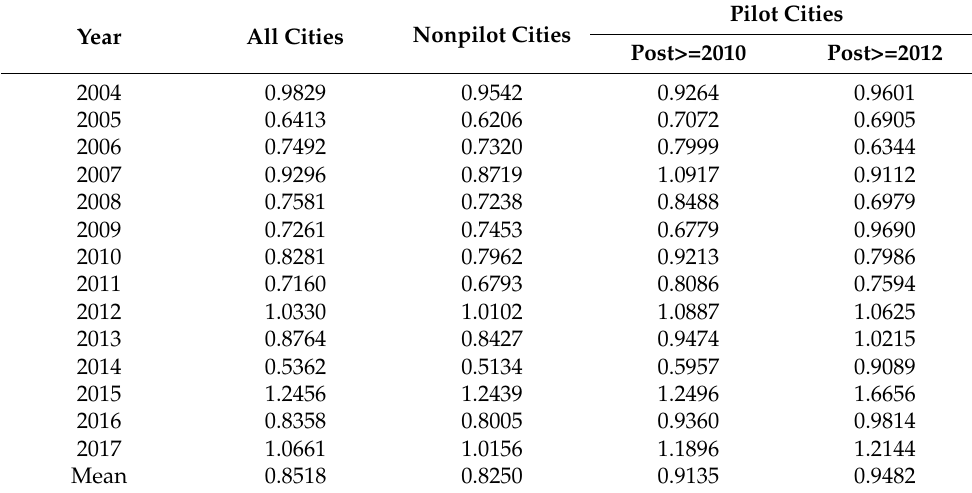
Table 14. Energy rebound effect: all cities, pilot cities, and nonpilot